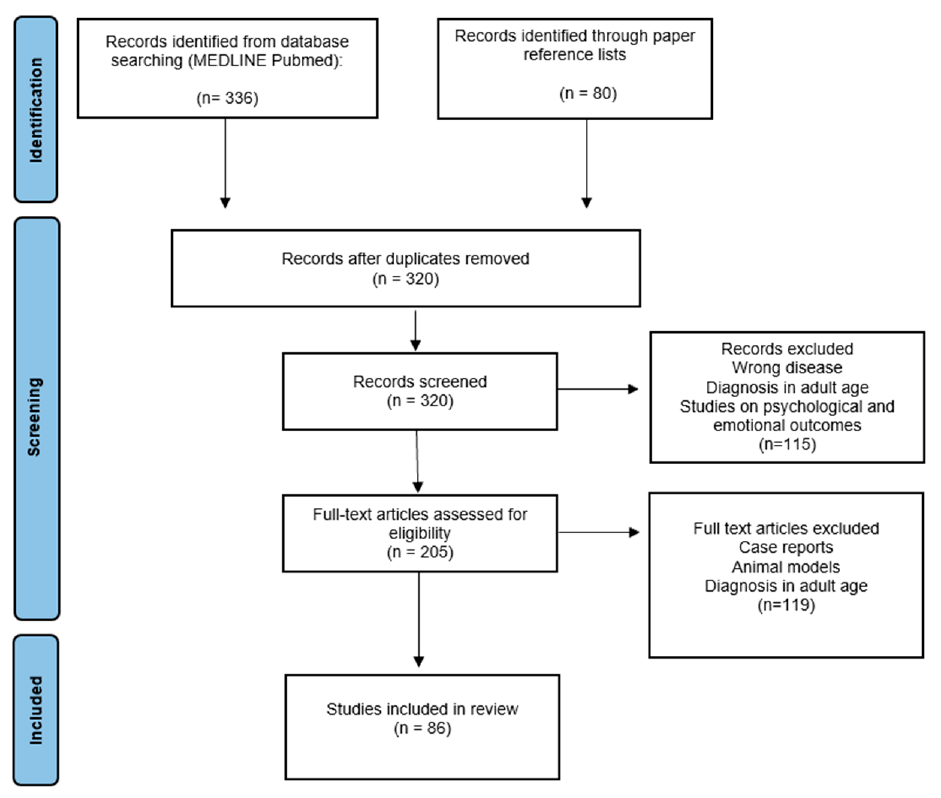
Figure 2. PRISMA flow diagram for selection of articles.